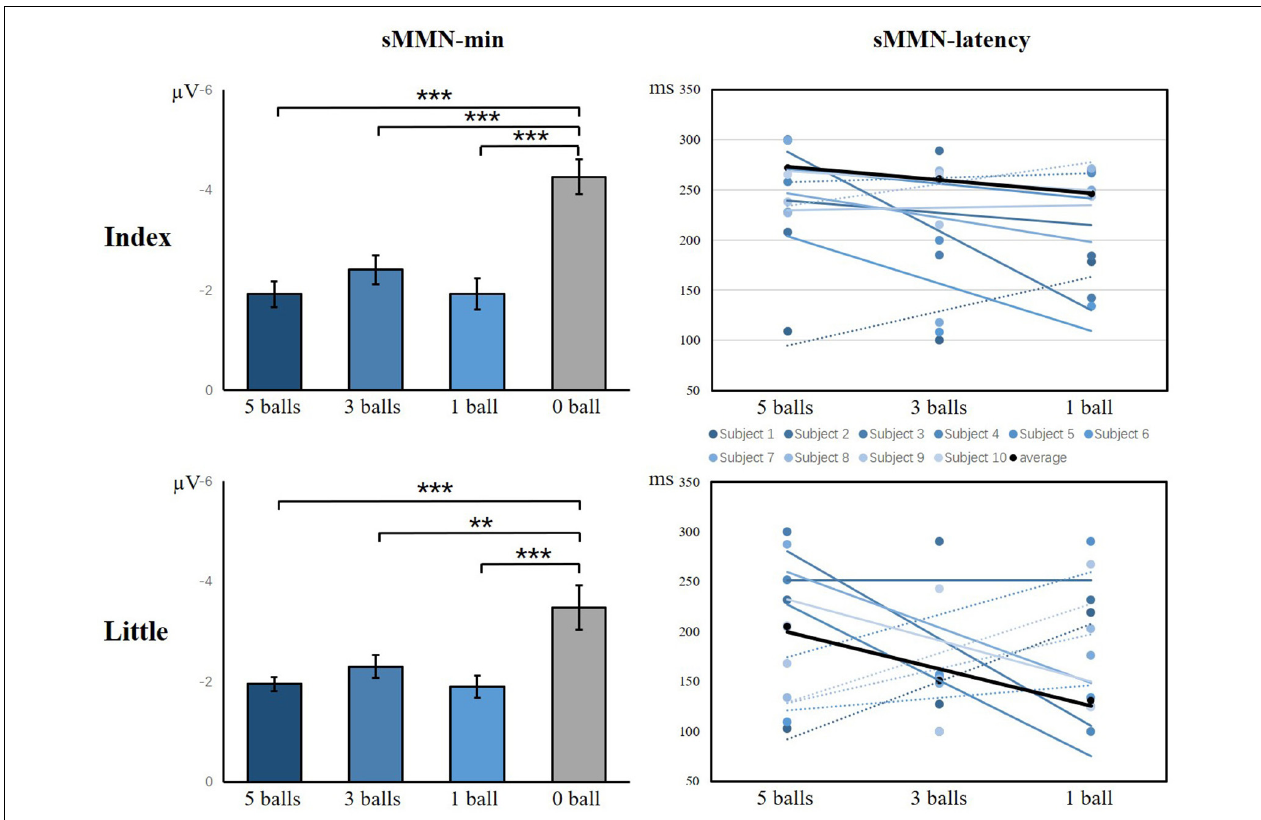
FIGURE 9 | The minimum amplitude and latency of the grand averaged sMMN for the index and little fingers. The sMMN-min compares the differences between task conditions and control conditions. The sMMN latency compares differences between task conditions and the latency trend of all participants are shown (** p < 0.01; *** p <